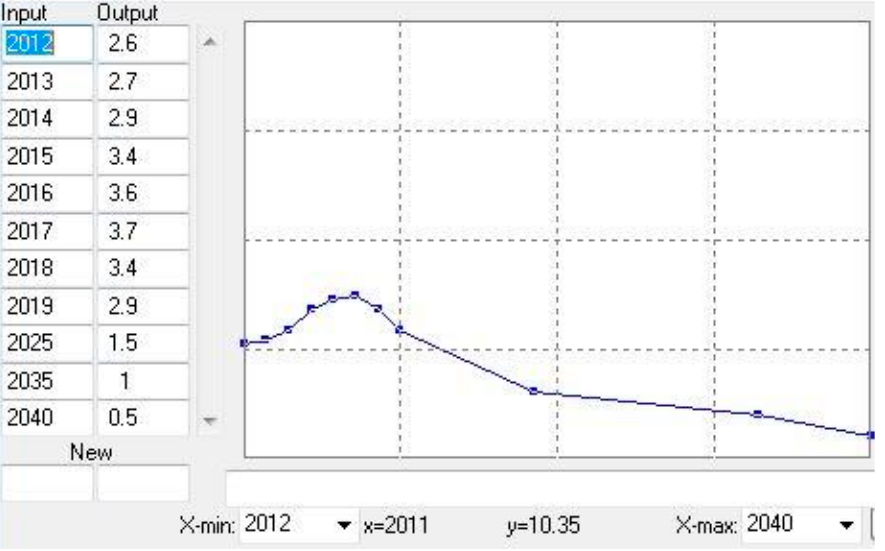
Figure 4. Trend in the car growth over the years.